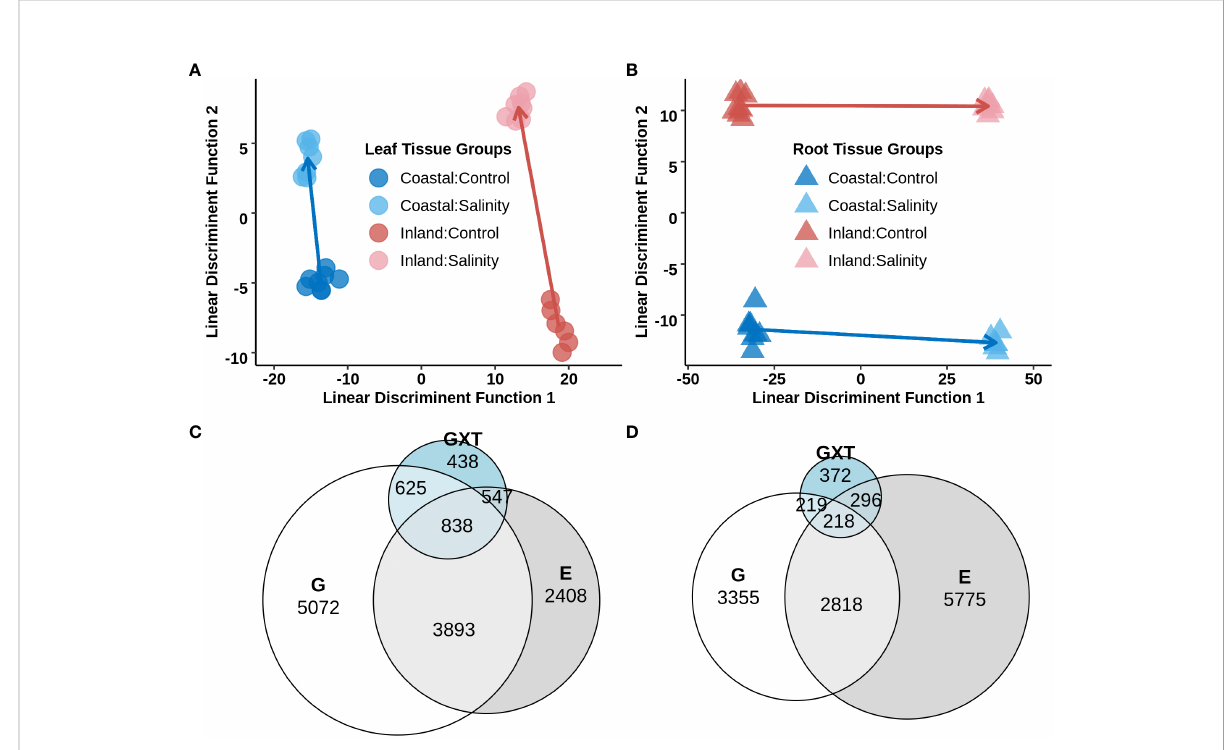
FIGURE 4 Differential gene expression in leaf and root tissues of the inland (HAL2) and coastal (FIL2) genotype of P. hallii in response to salinity stress. Top panel: (A, B) Discriminant Analysis of Principal Components (DAPC) on the normalized expression of genes from leaf (left, A ) and root (right, B ) tissues. Each point represents a single TAGSeq library and axes represents the fi rst two linear discriminant functions. Symbols representing tissue types and genotype x treatment combinations are marked with different fi lled colors. Bottom pane: (C, D) Venn diagram for signi fi cant DEGs detected for Genotype (G), Treatment (T), and the interaction of Genotype with Treatment (GxT) as fi xed effect for leaf and root tissue